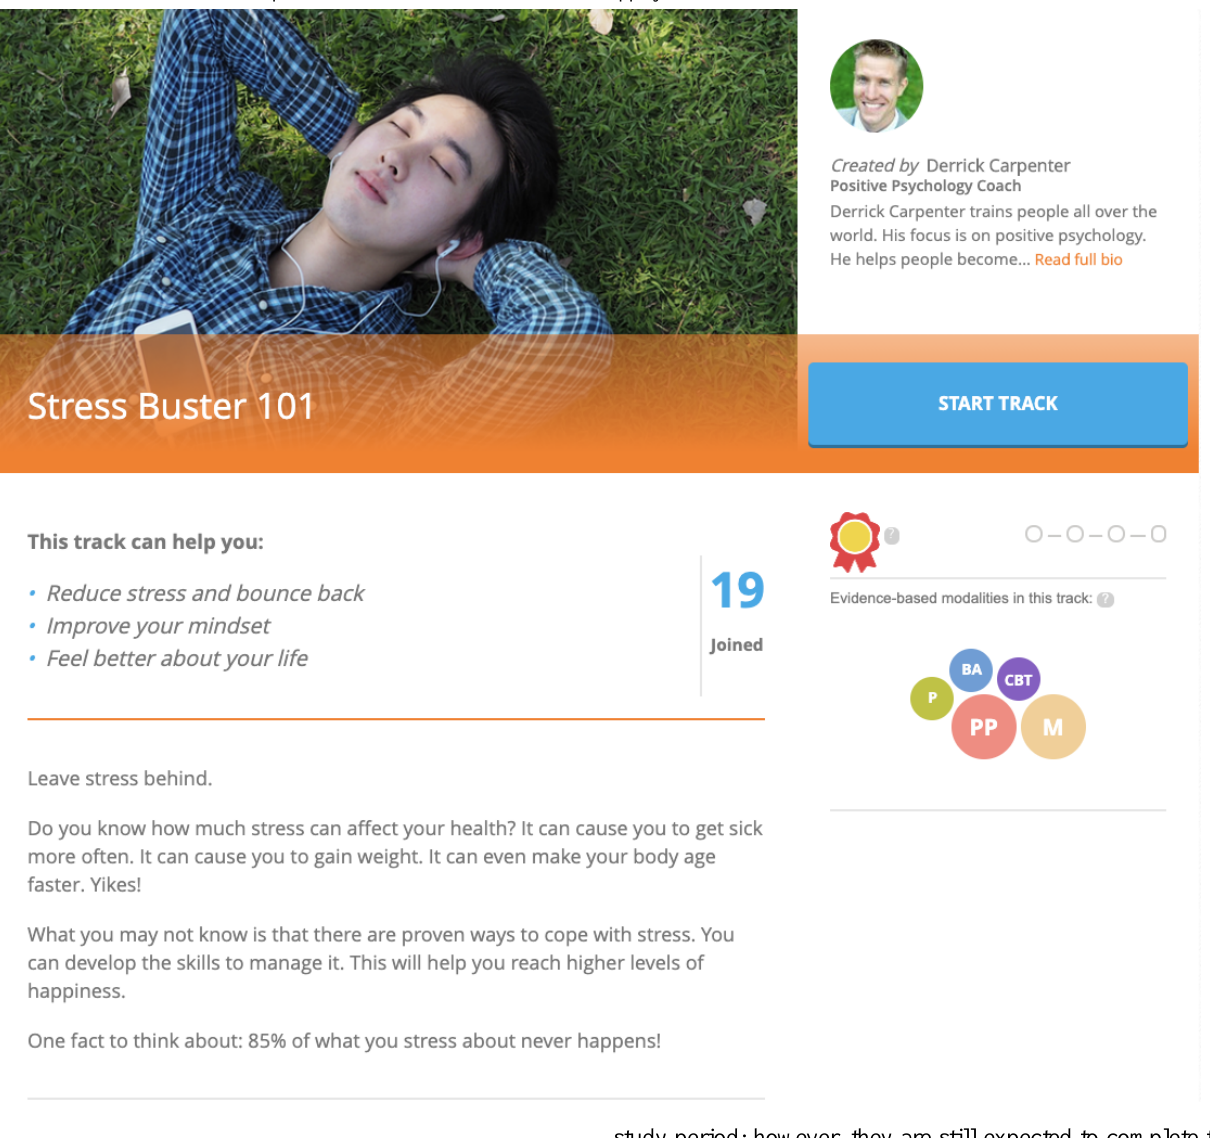
Wait-list Control